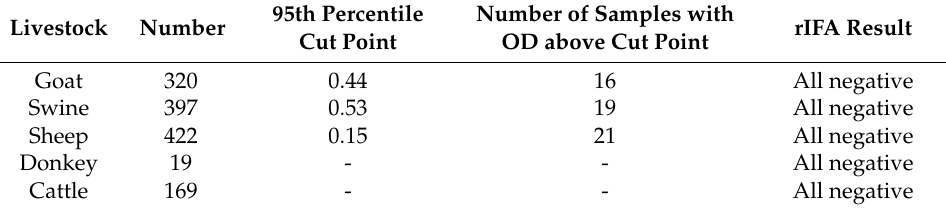
Table 4. Confirmation of most reactive livestock samples with